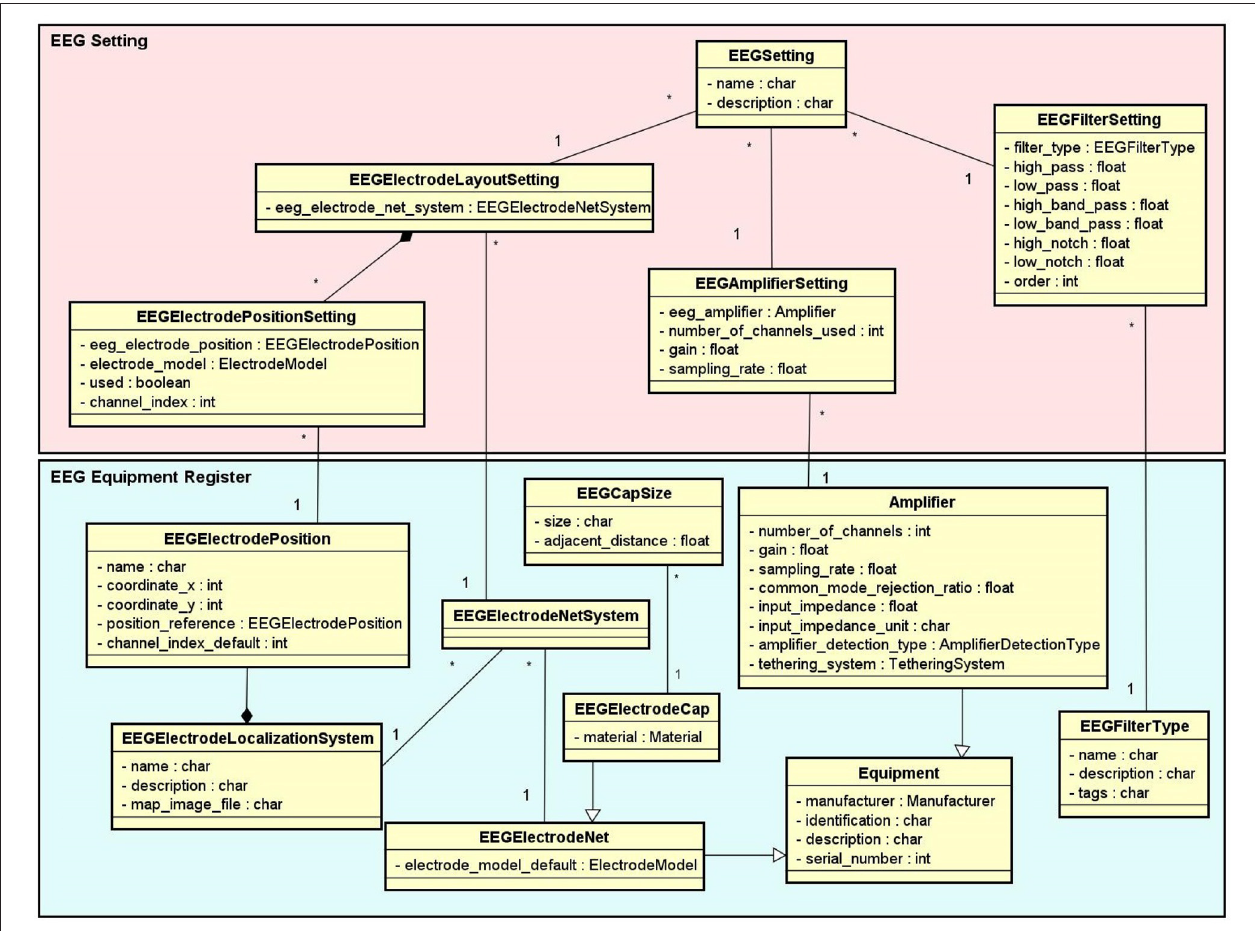
FIGURE 3 | EEG Setting and Equipment Register conceptual data schemas. The EEG Equipment Register schema contains the entity types with the technical characterization associated to a given EEG setup, such as amplifier, filter, electrode net, electrode cap, electrode localization system, etc. The EEG Setting schema contains the entity types which represent the configurations of the EEG equipment used in each step of an EEG